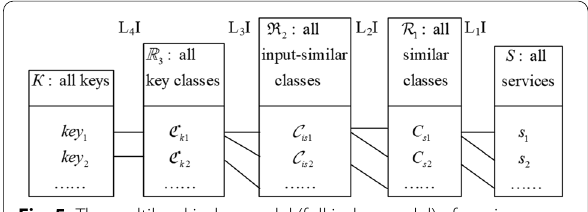
Fig. 5 The multilevel index model (full index model) of